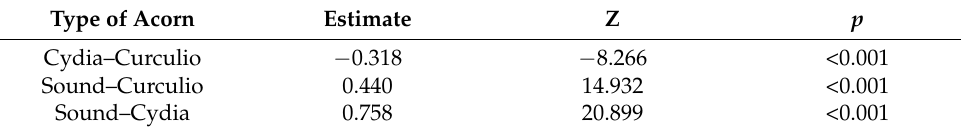
Figure 3. Acorn volume (cm 3 ) of the three different types of grown acorns. Dots show the mean per category and error bars the standard deviation of the mean. Table 1. Results of the Tukey post hoc pairwise comparison test in acorn volume